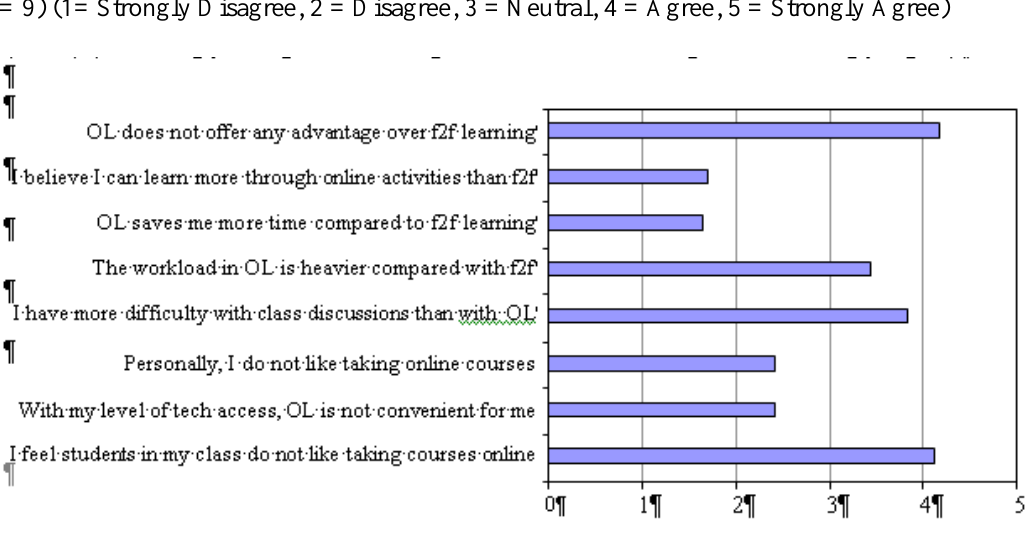
Figure 1. Mean ratings of students' agreement with statements regarding Online Learning (OL) (N = 9) (1= Strongly Disagree, 2 = Disagree, 3 = Neutral, 4 = Agree, 5 = Strongly Agree)